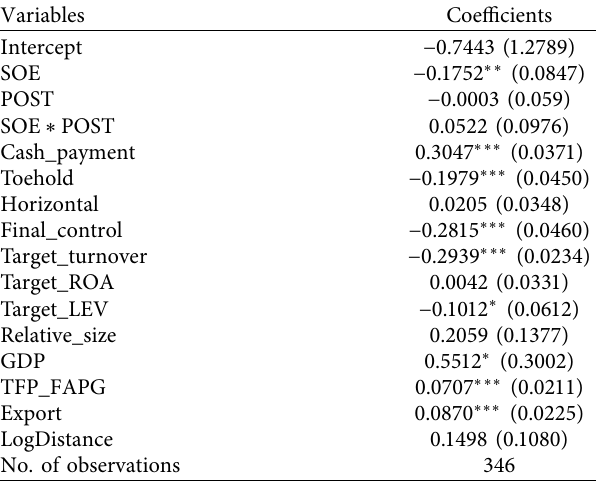
Table 10: Difference-in-difference regression